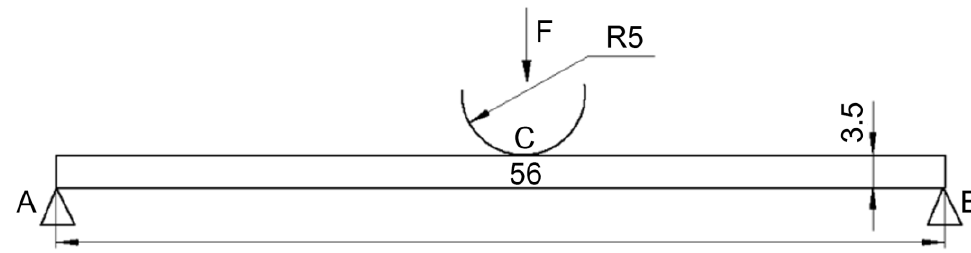
Figure 9. The computational domain diagram for simulation of the three-point flexural tests.